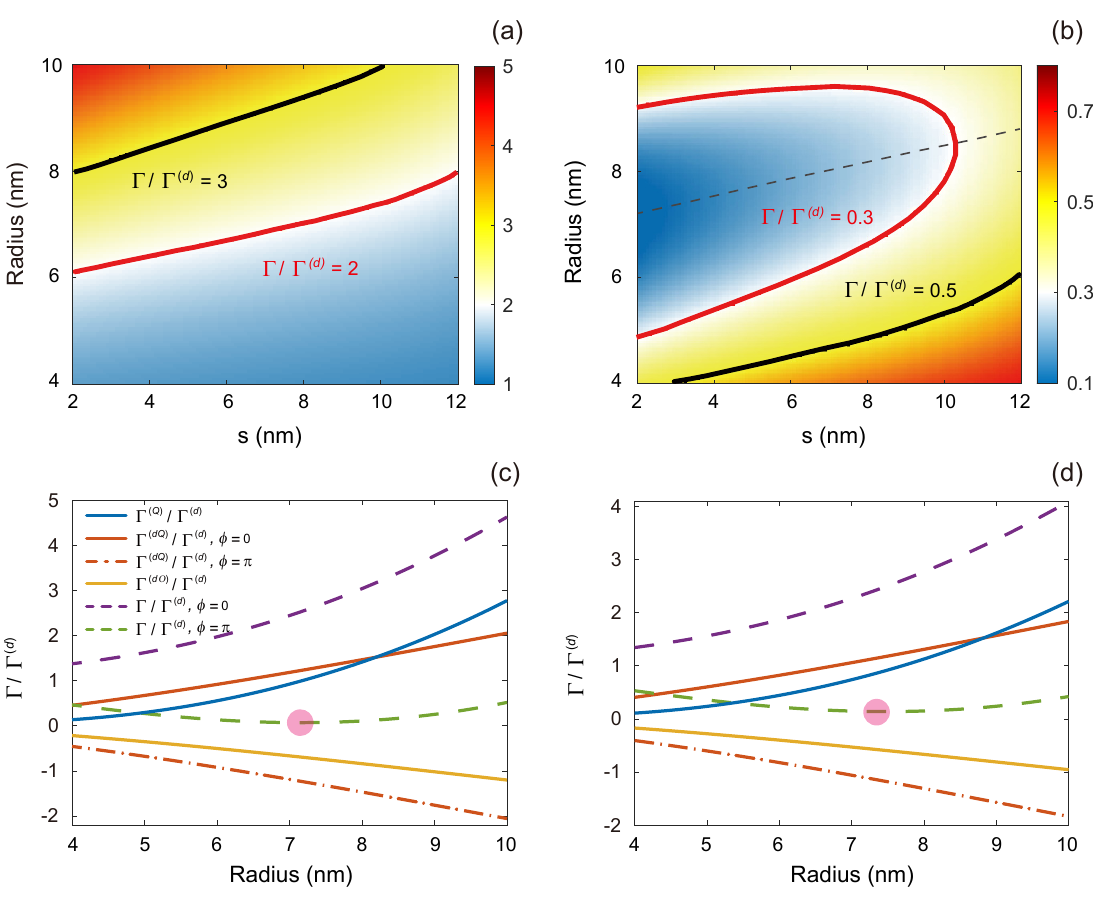
,𝜙 ) ∕Γ ( d ) ( r as a 0 0 ) ,𝜙 ) for a ∕Γ ( d ) ( r 0 ) 0 ,𝜙 ) and Γ ( dO ) ( r ,𝜙 ) versus QD radius for ), Γ ( dQ ) ( r 0 0 0